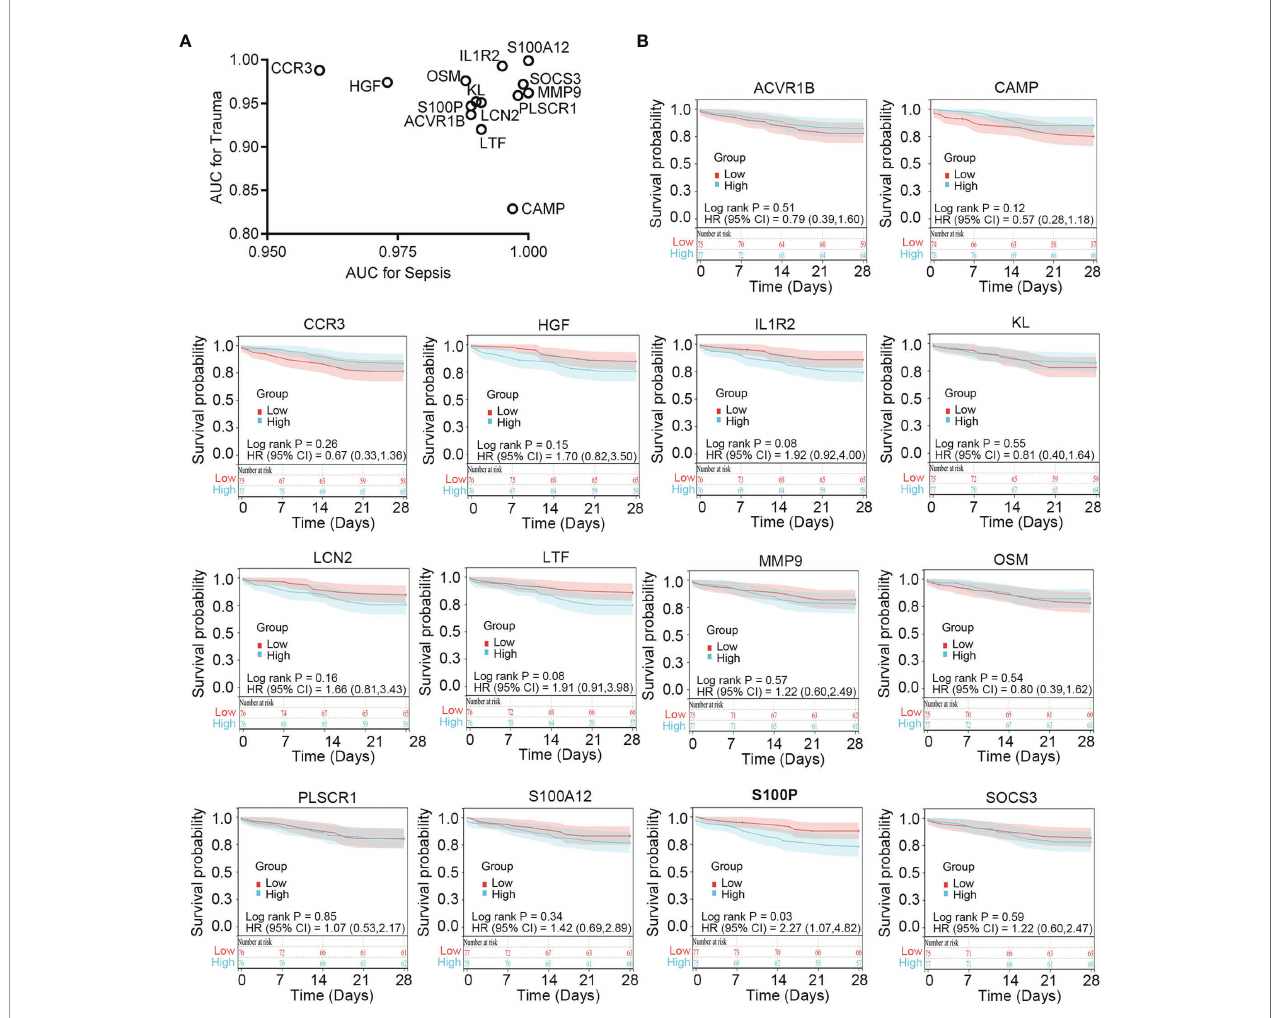
FIGURE 4 | Clinical relevance of the immune-related common genes in trauma and sepsis. (A) ROC curve analysis of the immune-related common genes in trauma and sepsis. (B) Survival analysis of the immune-related common genes in sepsis. ROC, receiver operating characteristic; AUC, area under the ROC